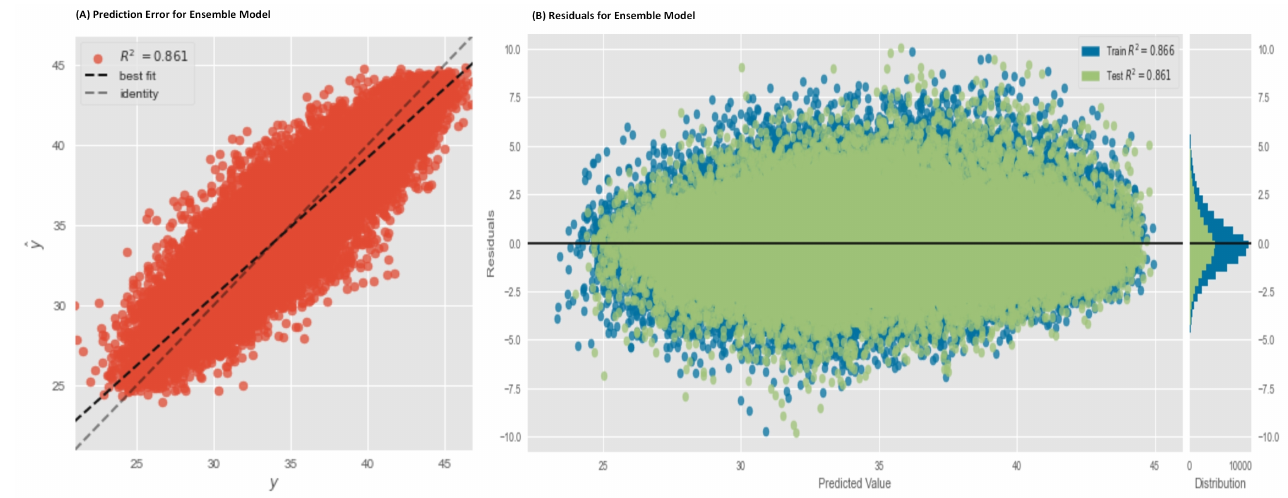
Figure 18. Accuracy of Ensemble Model for Maximum Temperature forecasting.